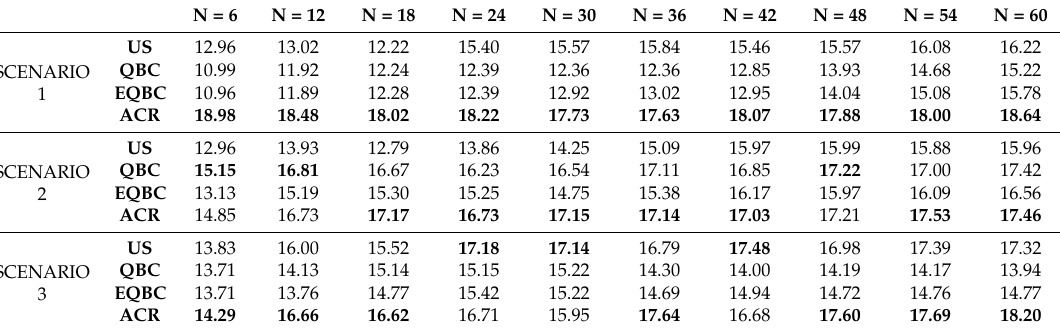
Table 5. LEI (SVM) in Scenarios 1–3 (%).